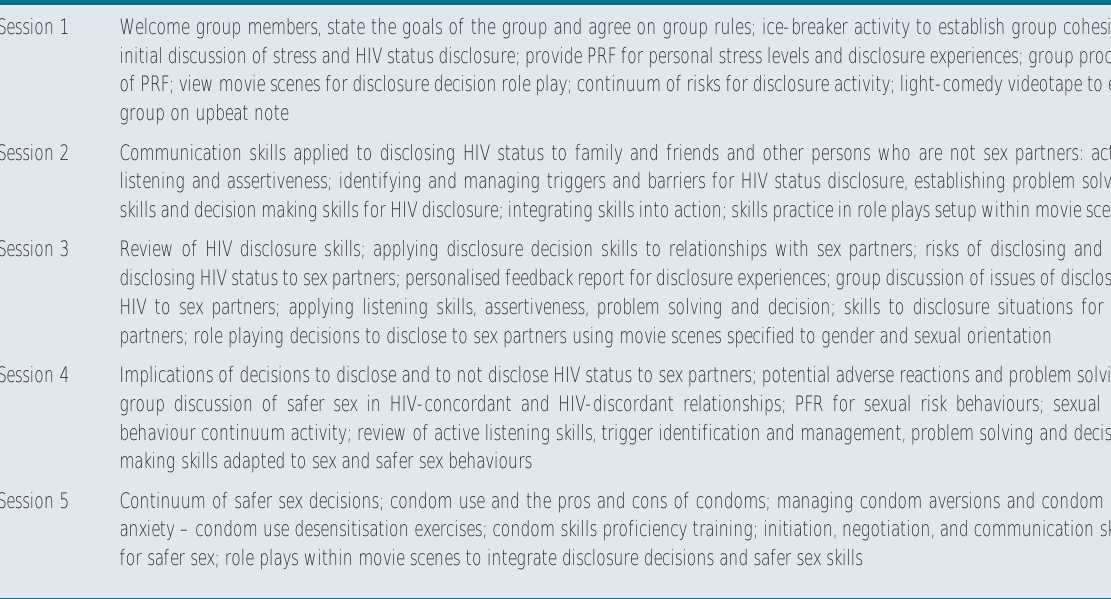
Fig. 2. Social cognitive theory-based coping efficacy model for HIV risk behaviour change in the Healthy Relationships TABLE II. SESSION CONTENT FOR THE SOCIAL COGNITIVE HIV RISK REDUCTION INTERVENTION HEALTHY RELATIONSHIPS